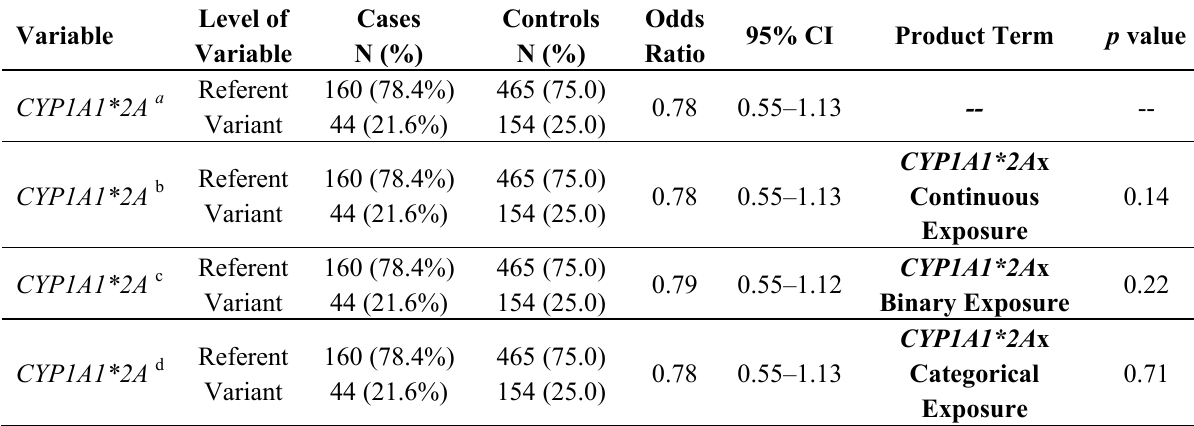
Table 3. Unconditional multivariable logistic regression analysis of association between breast cancer risk, fungicide exposure and CYP1A1*2A allele, PEI,